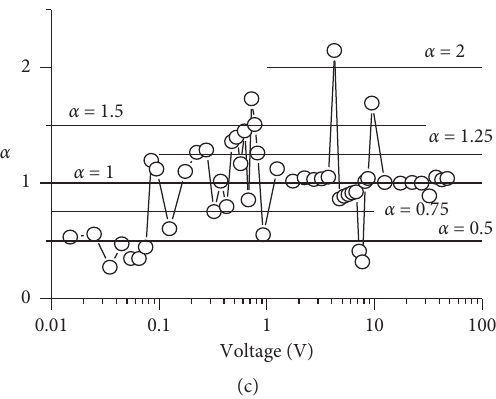
Figure 5: I-V characteristics (a) and their dimensionless sensitivity (b, c) of the TiO